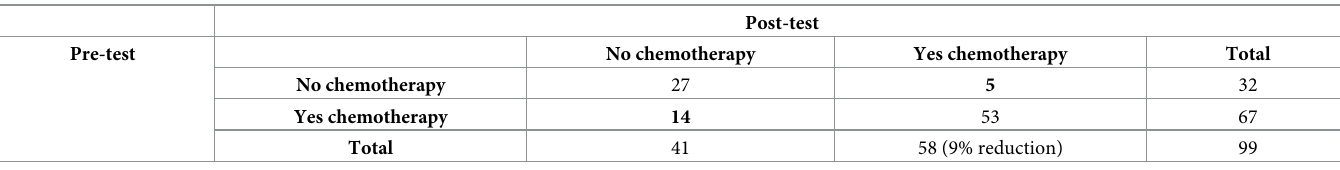
Table 3. Pre- and post-EndoPredict chemotherapy consensus.